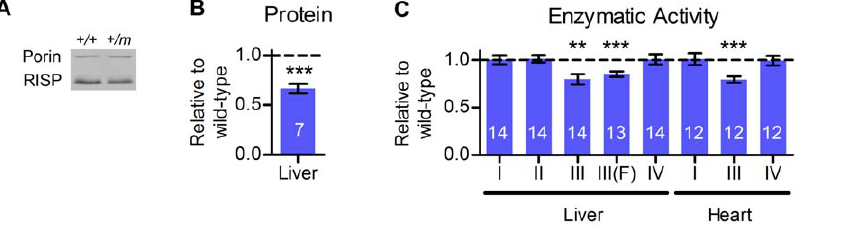
Figure 2. Young Risp + /P224S mice have decreased RISP protein and complex III enzymatic activity. ( A ) A representative western blot showing RISP protein levels in mitochondria isolated from liver of 3-month-old female adults. A wild-type/heterozygous littermate pair is shown (‘ m ’ denotes the knock-in mutant allele P224S). ( B ) Densitometry was used to quantify RISP relative to porin. All measurements were made in wild-type/ heterozygote littermate pairs, and results are expressed as the effect of Risp heterozygosity relative to wild-type within each pair. ( C ) Enzymatic activity of complexes of the mitochondrial ETC (complex I, II, III or IV) was determined in disrupted mitochondria, using appropriate substrates and inhibitors to isolate the activity of each complex. All measurements were made in wild-type/heterozygote littermate pairs, and results are expressed as the effect of Risp heterozygosity relative to wild-type within each pair. All results are for male mice, except where indicated (as F, for female). Actual densitometry values for (A) and enzymatic activities for all samples (C) are shown in Table S2. Sample sizes (i.e., number of wild-type/heterozygous littermate pairs) are shown superimposed on each bar. ‘**’ denotes p=0.001 to 0.01 and ‘***’ denotes p , 0.001 vs. 1.0.